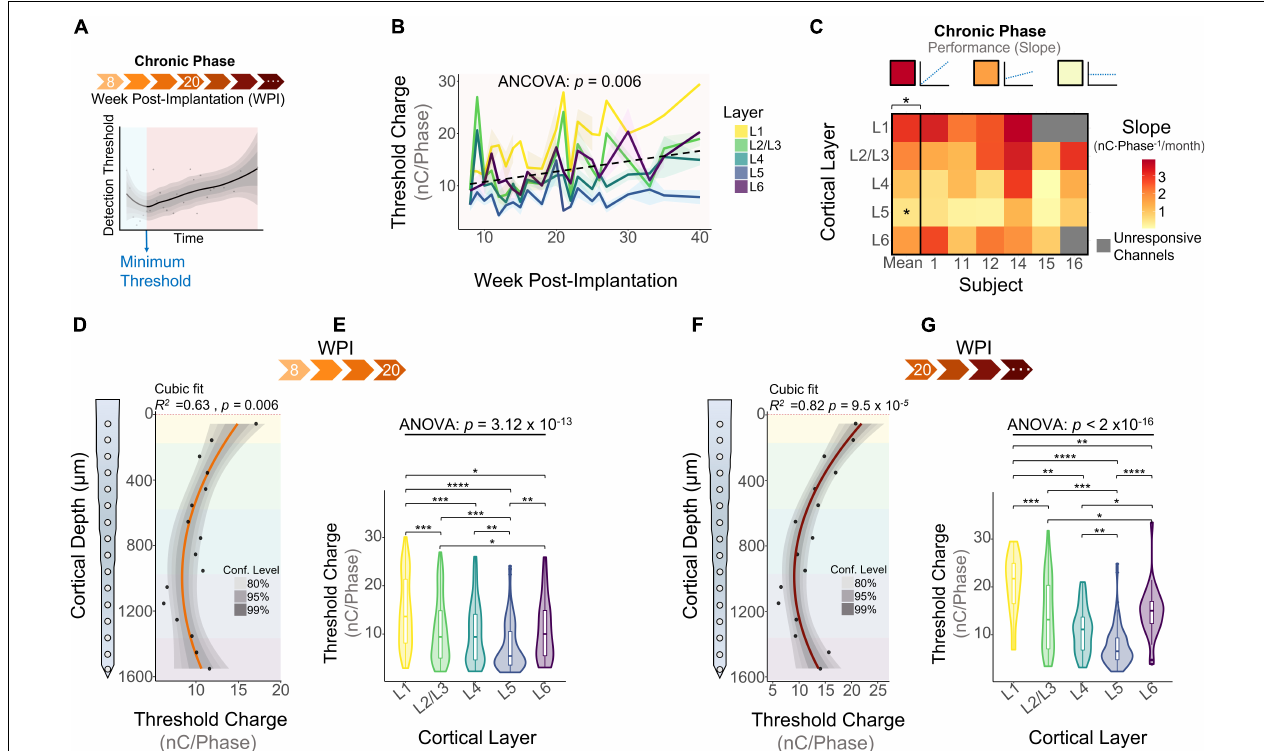
FIGURE 5 | Microstimulation detection thresholds during the chronic phase. (A) Graphical representation of longitudinal threshold showing the beginning of the chronic phase (orange shade) after the week of minimum thresholds. (B) Average detection thresholds during the chronic phase. Dashed line represents a linear regression of the mean. (C) Heatmap of the slope of thresholds between the week of minimum threshold and the last week of threshold across subjects. ICMS Sensitivity across cortical depth and laminar quantification during (D,E) 8–20 weeks-post-implantation and (F,G) > 20 WPI. Analysis of variance and pairwise comparisons between layers were performed with a one-way ANOVA with Tukey’s post-hoc test. Shaded areas in (B) indicate mean ± SEM. * p ≤ 0.05, ** p ≤ 0.01, *** p ≤ 0.001, **** p ≤